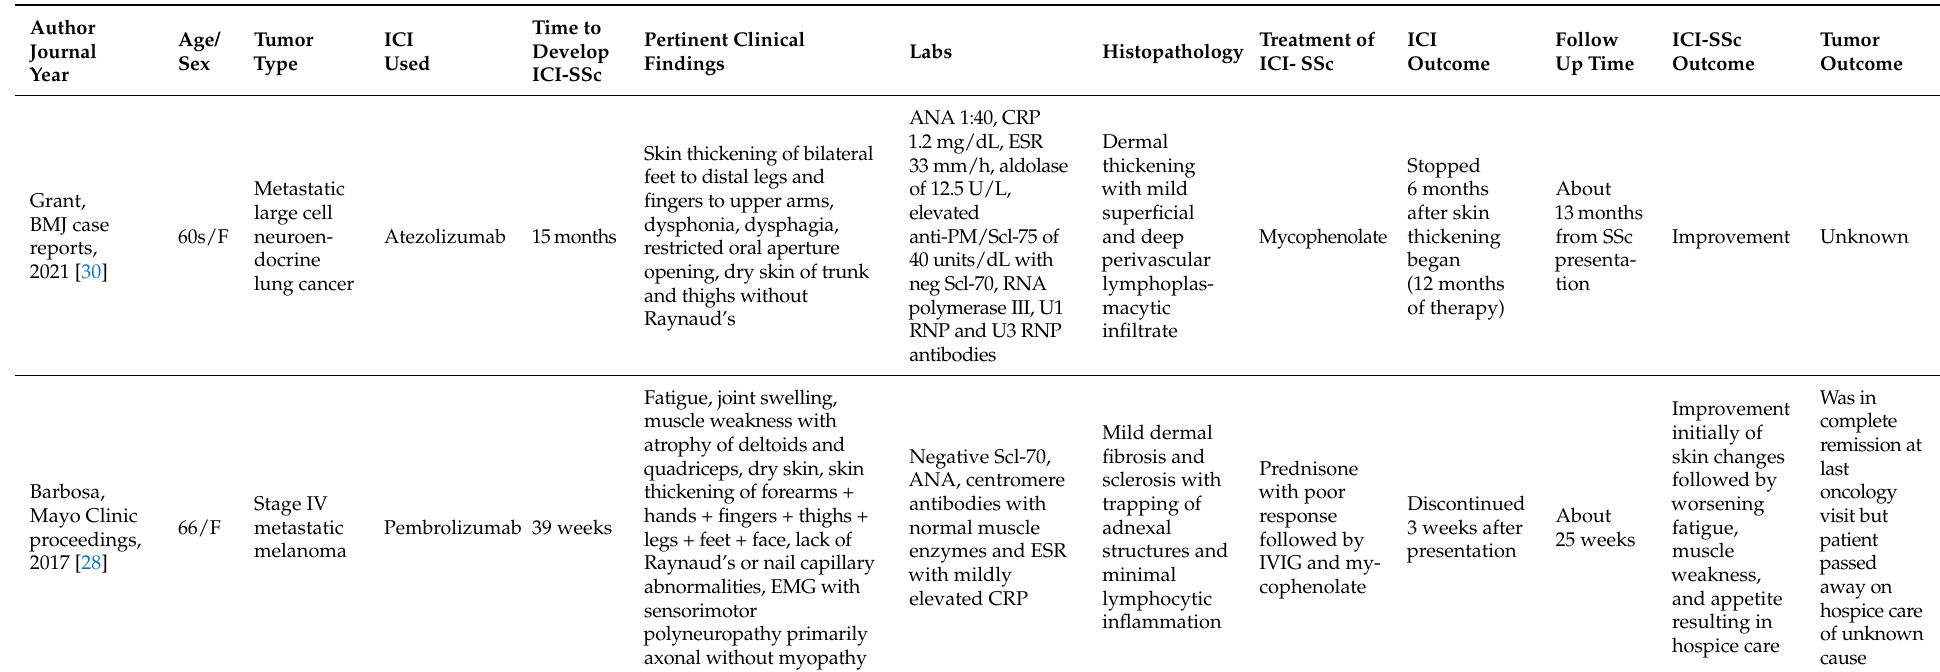
Table 1. Immune-checkpoint-inhibitor-associated scleroderma